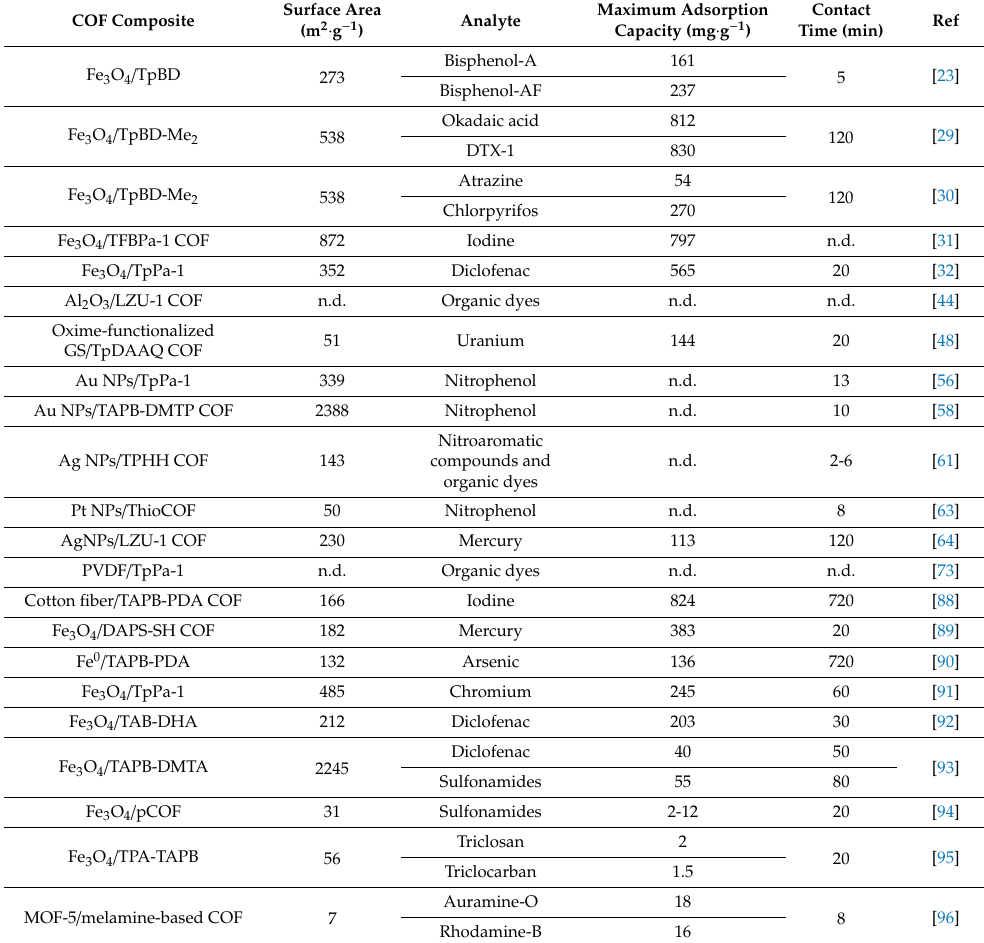
Table 2. Applications of COF composites for environmental remediation.